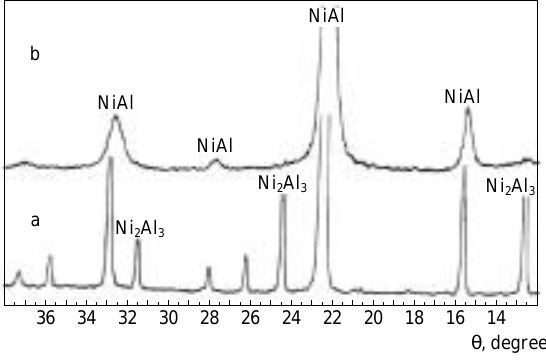
Fig. 8 X-ray patterns of the SHS product in the system Ni 40.8 wt.% Al (a), the same product after mechanical activation for 3